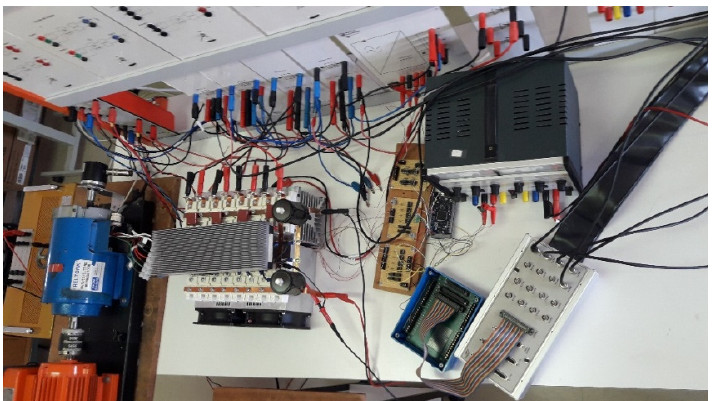
Figure 18. Top view photograph of the experimental setup.